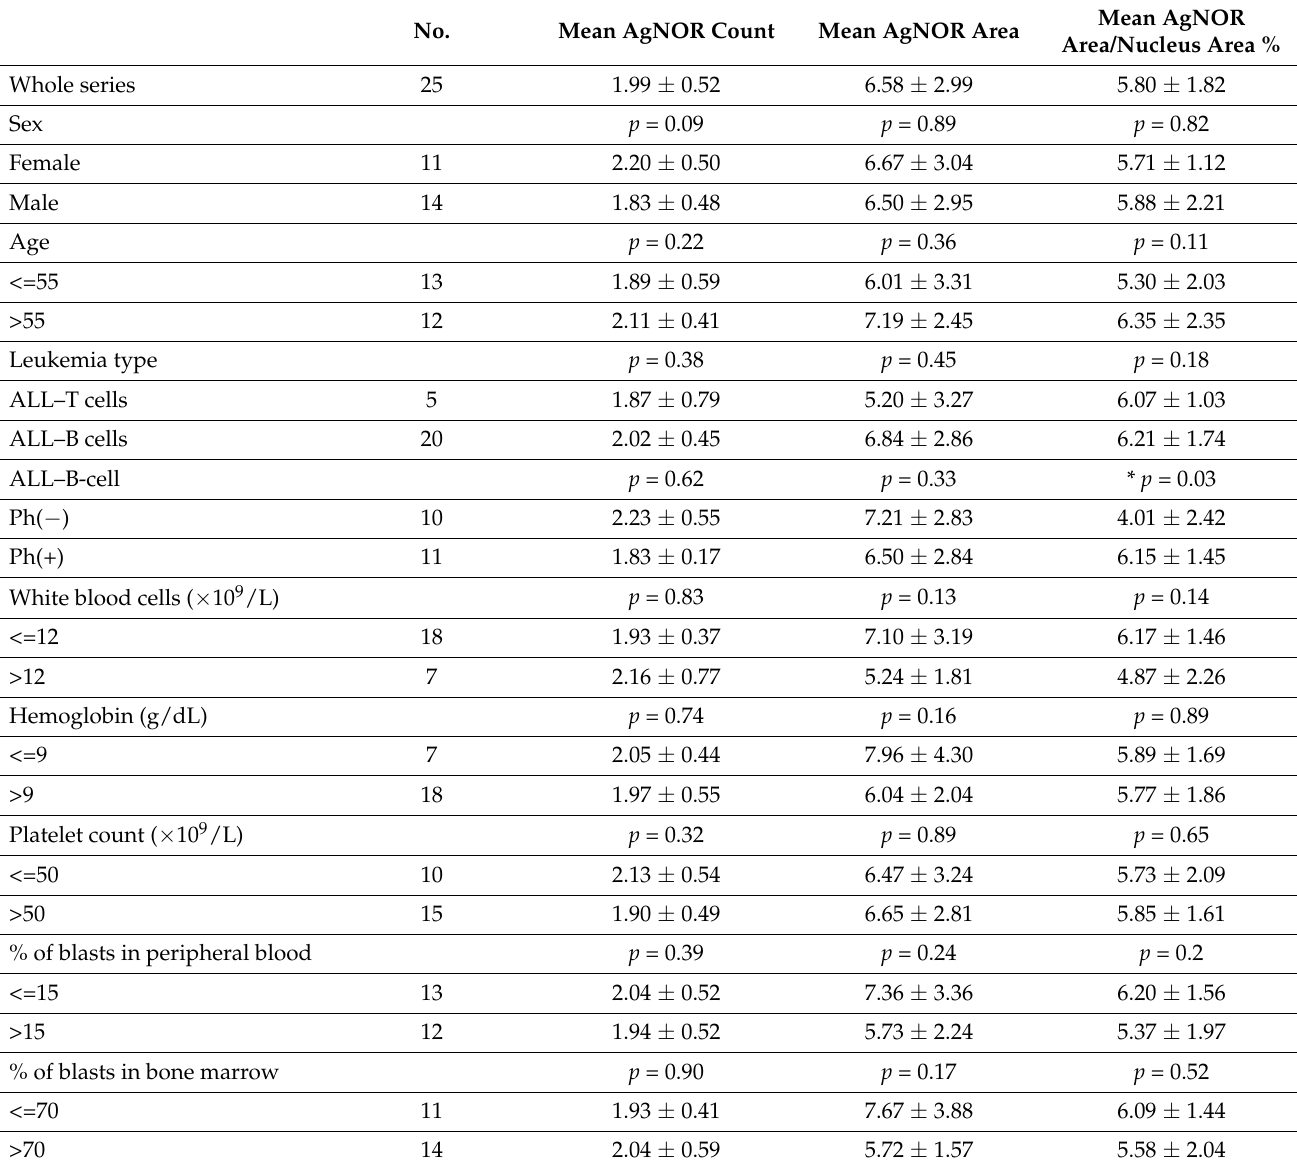
Table 3. Mean values of AgNOR indexes in the ALL patient